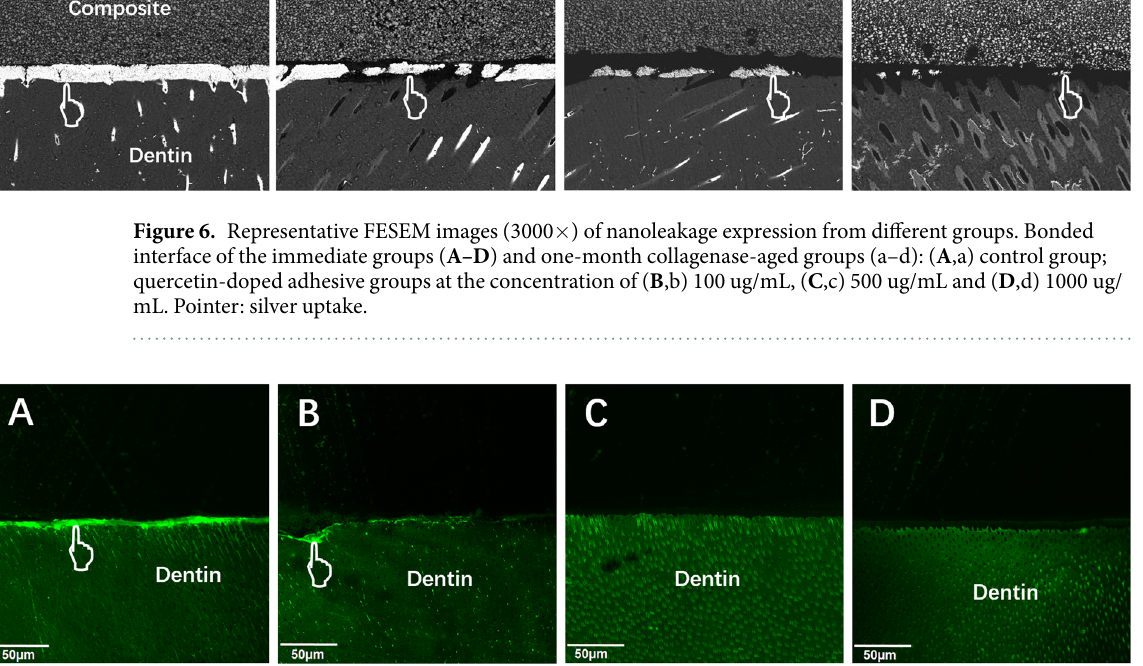
Figure 7. Confocal laser scanning microscopy images of in situ zymography labeled with quenched fluorescein- conjugated gelatin. ( A ) Control group; Quercetin-doped adhesive groups at the concentration of ( B ) 100 ug/mL, ( C ) 500 ug/mL and ( D ) 1000 ug/mL. Pointer: indicative of MMP